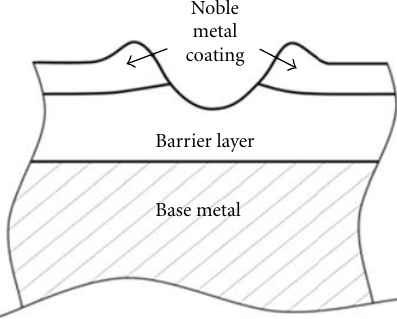
Figure 19: Wear pattern In total wearing o ff of the upper layer. Cross-section of plating system of electric contacts after the wear and fretting corrosion